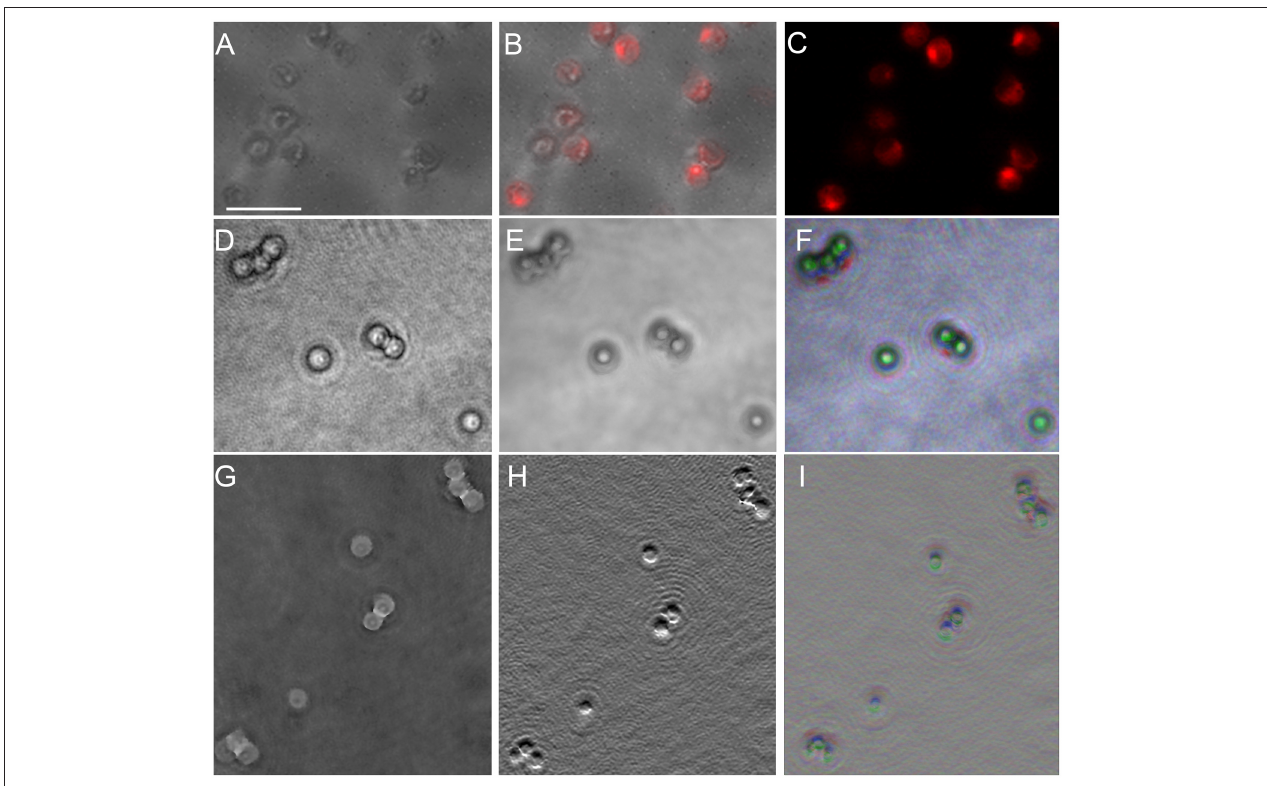
FIGURE 8 | Picocystis salinarum under light microscopy and DHM. Scale bar = 5 µ m. (A) DIC image. (B) Overlay of DIC and chlorophyll fluorescence (excite 488/emit 600 LP). (C) Chlorophyll fluorescence. (D) DHM intensity image in a selected z plane. (E) Median z-projection of amplitude images through 150 z-planes. (F) Depth-coded median z-projection of amplitude images through 150 z-planes. (G) DHM phase image in a selected z plane. (H) First y-derivative of phase image in a selected plane (similar to DIC). (I) Depth-coded median projection of first derivative of phase through 150z